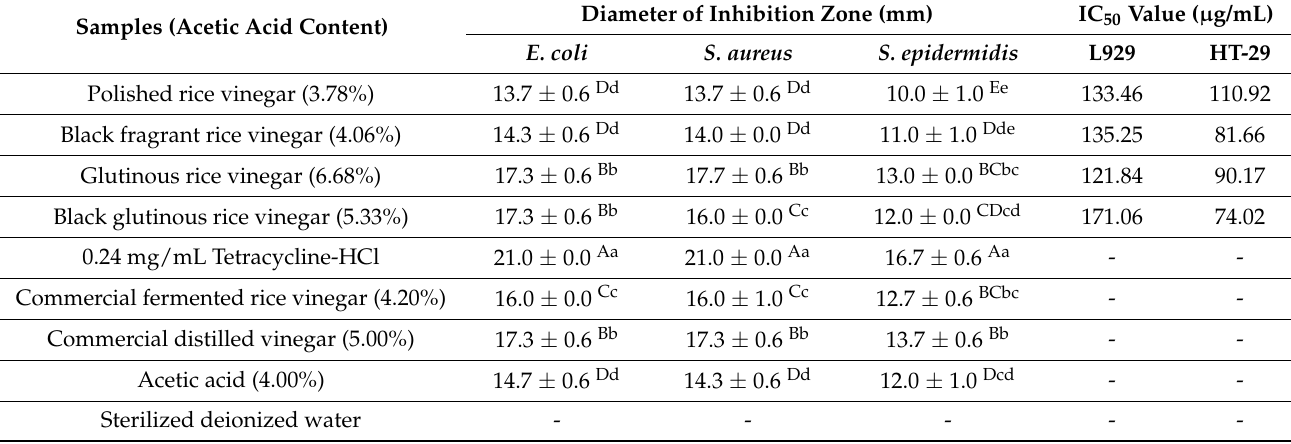
Table 3. Diameter of the inhibition zone of Thai rice vinegars and cytotoxicity of rice vinegars toward the cancer cell lines. Samples (Acetic Acid